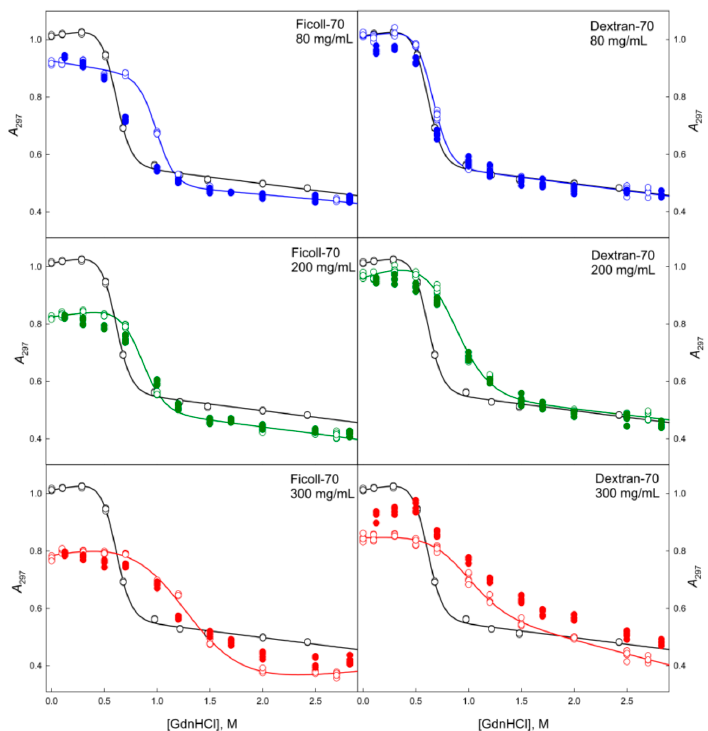
Figure 5. Unfolding/refolding transitions of GGBP in the presence of different concentrations of Ficoll- 70 and Dextran-70 recorded by the dependence of parameter A = F 320 / F 365 on GdnHCl concentration. The excitation wavelength was 297 nm. The designations as in Figure 4.